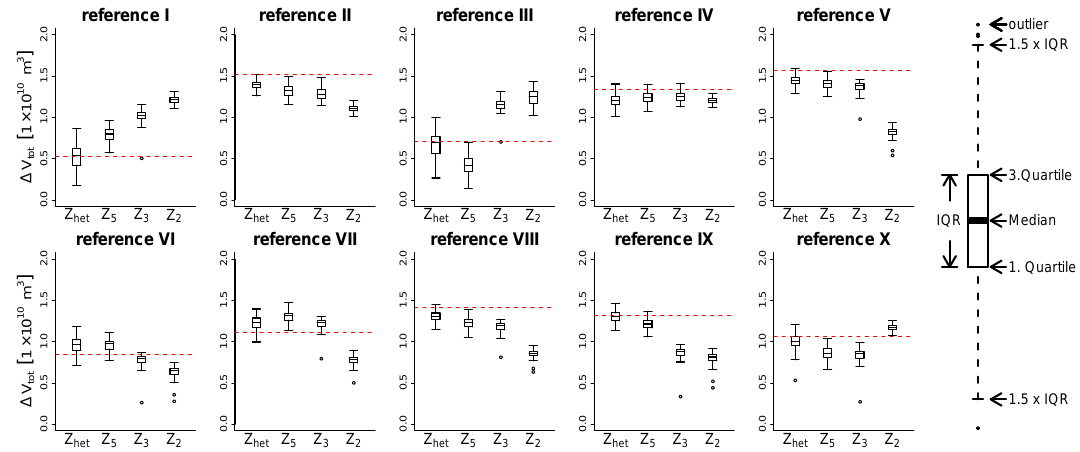
Fig. 8. Total amount of water exchanged between river and aquifer over the whole simulation period (609 days) for scenario A. Red lines mark the water exchange for the different reference runs. On the right-hand side the description of the boxplots is illustrated.